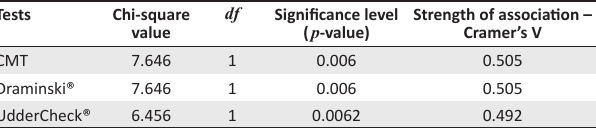
TABLE 4: Association between the PortaSCC® test and other tests used to screen quarter milk samples for the presence of subclinical mastitis. df Tests Chi-square value